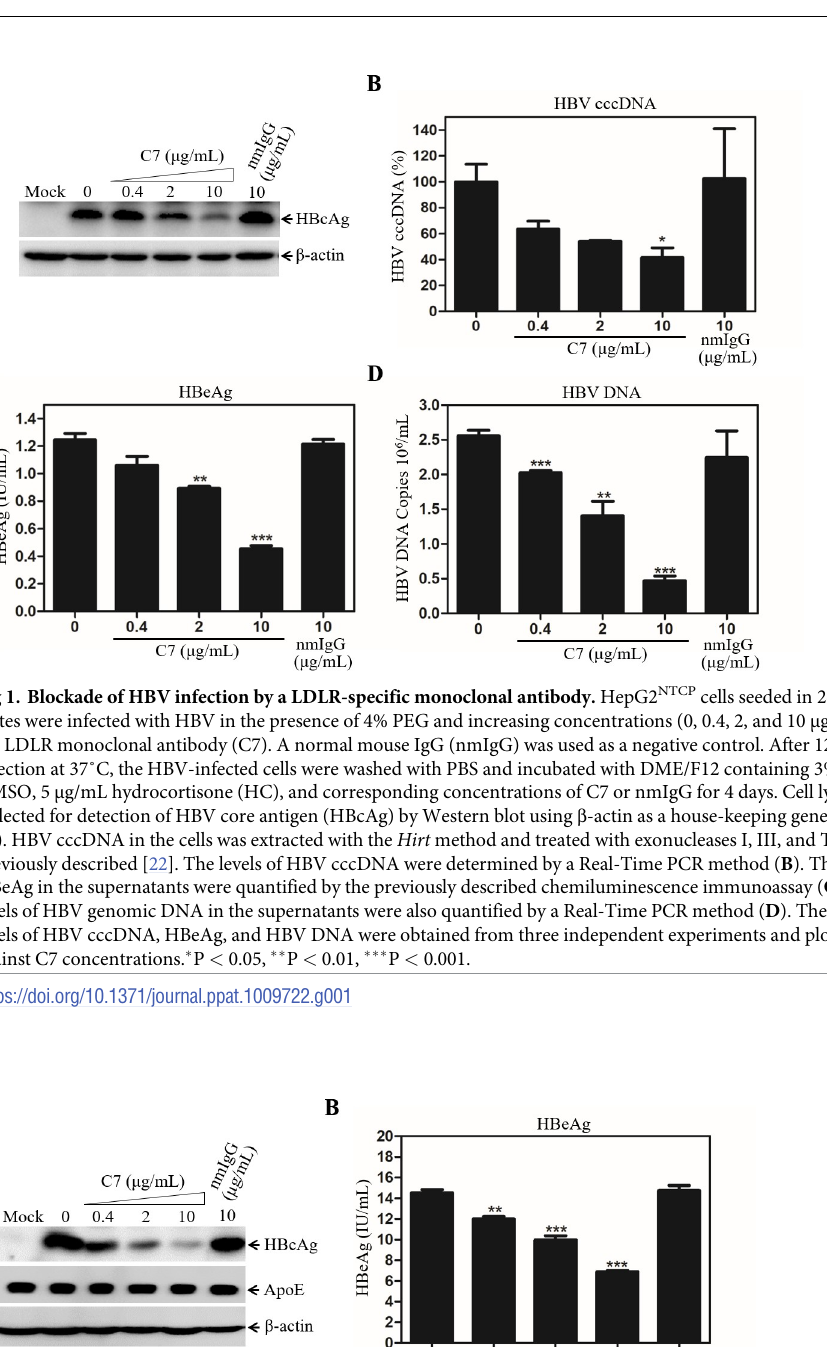
PLOS Pathogens| https://doi.org/10.1371/journal.ppat.1009722 July 22,